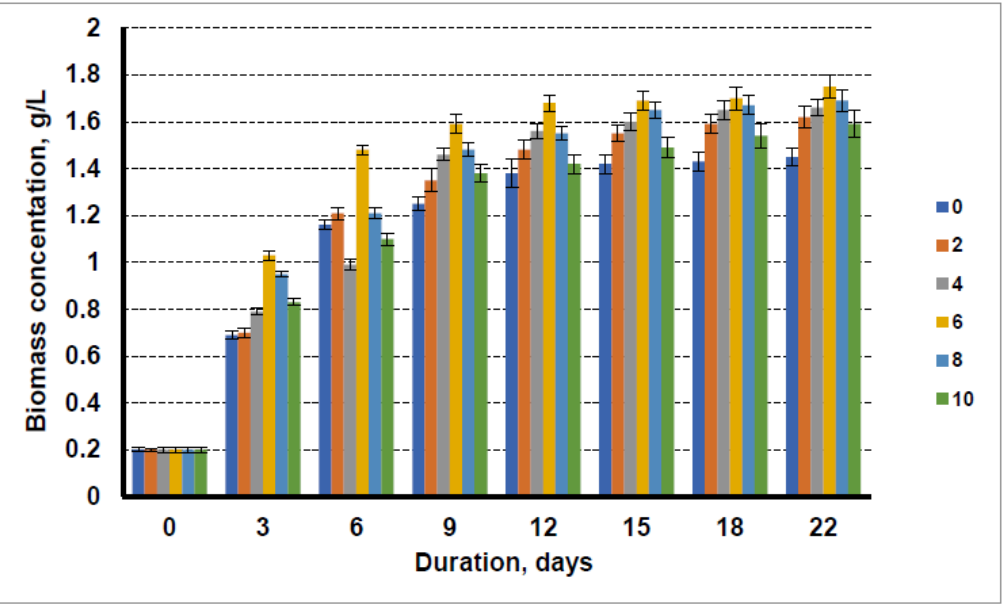
Figure 3. Growth dynamics of microalgae in the nutrient medium with the liquid fraction after biogas production from distillers ’ grain with a nitrogen concentration of 0.08 g/L and glycerol concentrations of 0 g/L, 2 g/L, 4 g/L, 6 g/L, 8 g/L, and 10